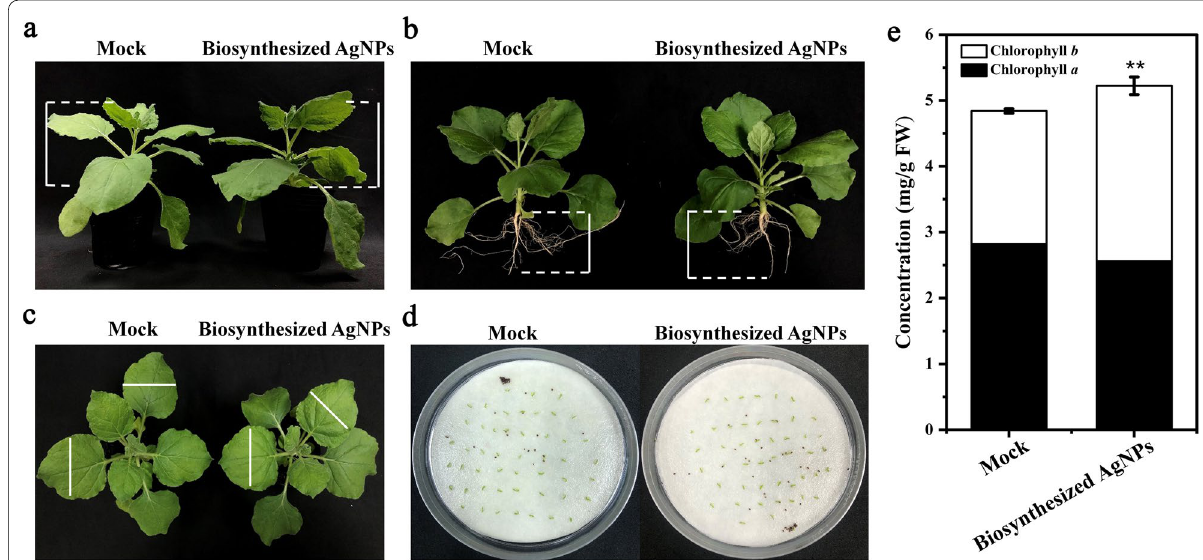
Fig. 6 Effects of biosynthesized AgNPs on plant growth and chlorophyll content. a – c Comparison of plant height ( a ), root length ( b ), and leaf width ( c ) between biosynthesized AgNPs and sterilized distilled water treated Nicotiana benthamiana plants. d Seed germination under treatment with biosynthesized AgNPs or sterilized distilled water. e Column diagram showing chlorophyll contents in plants treated with biosynthesized AgNPs or sterilized distilled water. The leaf samples were collected after treatment with 1.2 μg/mL biosynthesized AgNPs for 5 times (once per day). Mock, negative control (treated with sterilized distilled water). The data are mean standard error ( n 3). Data analysis was performed using Student’s t ± = test (. ∗∗ 0.001 < P < 0.01)